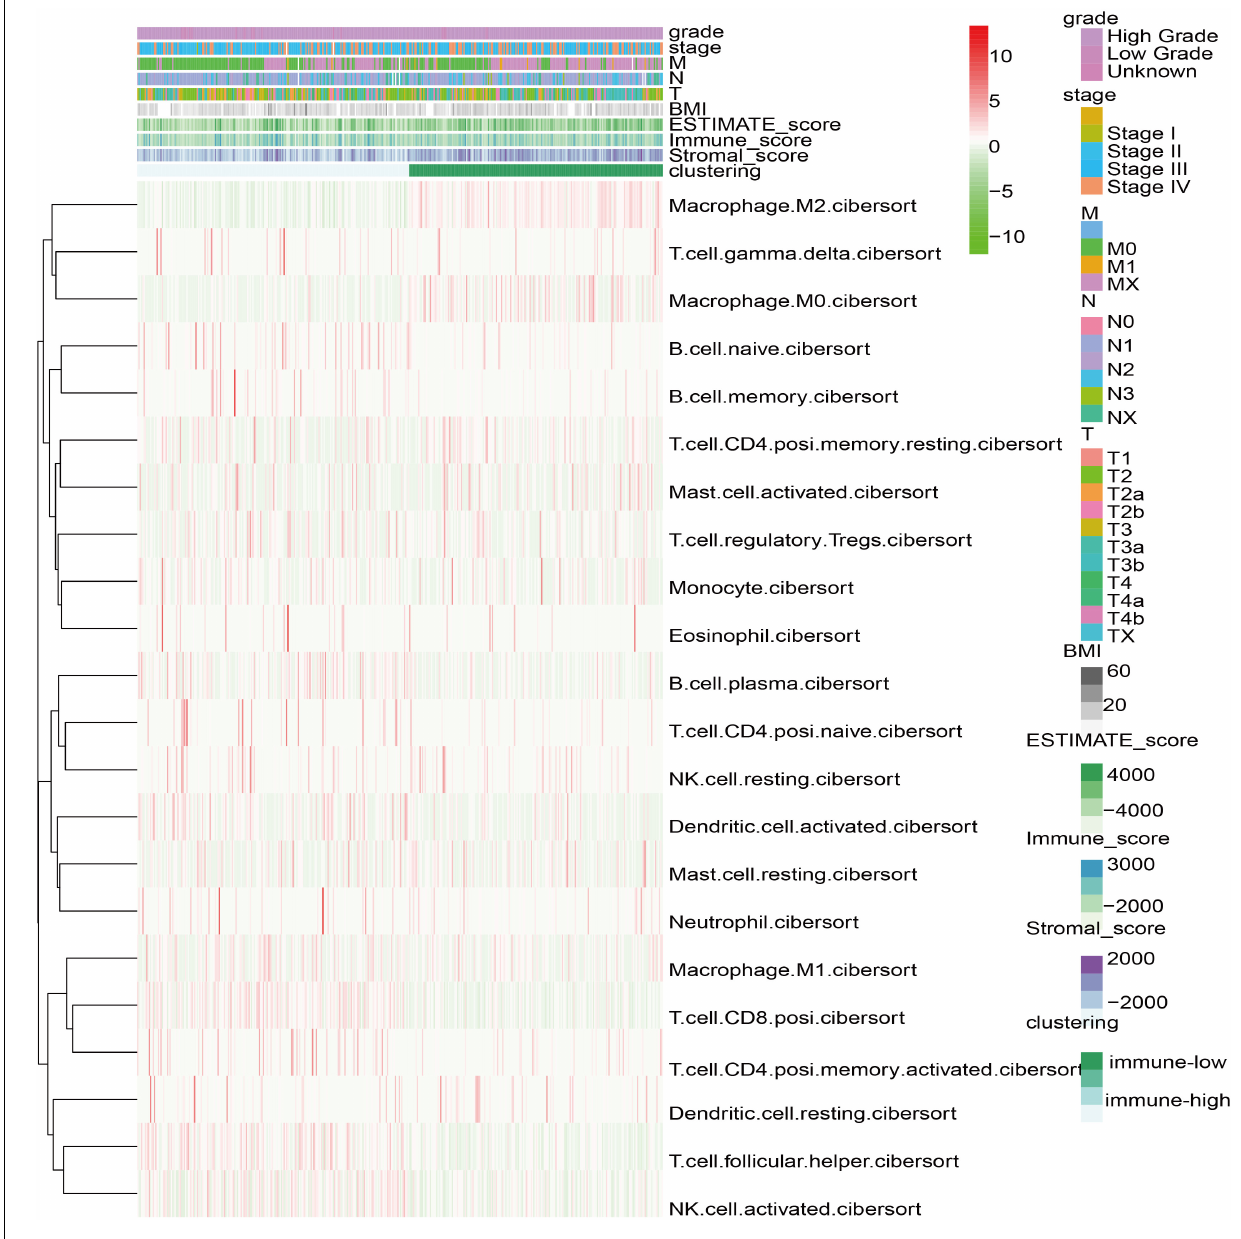
Frontiers in Cell and Developmental Biology |